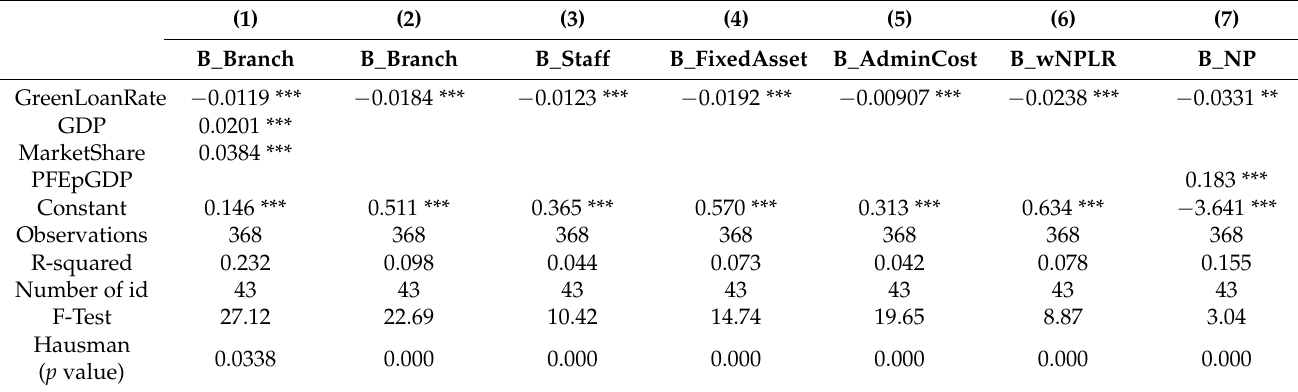
Table 7. Regression results of the green credit ratio on the slack